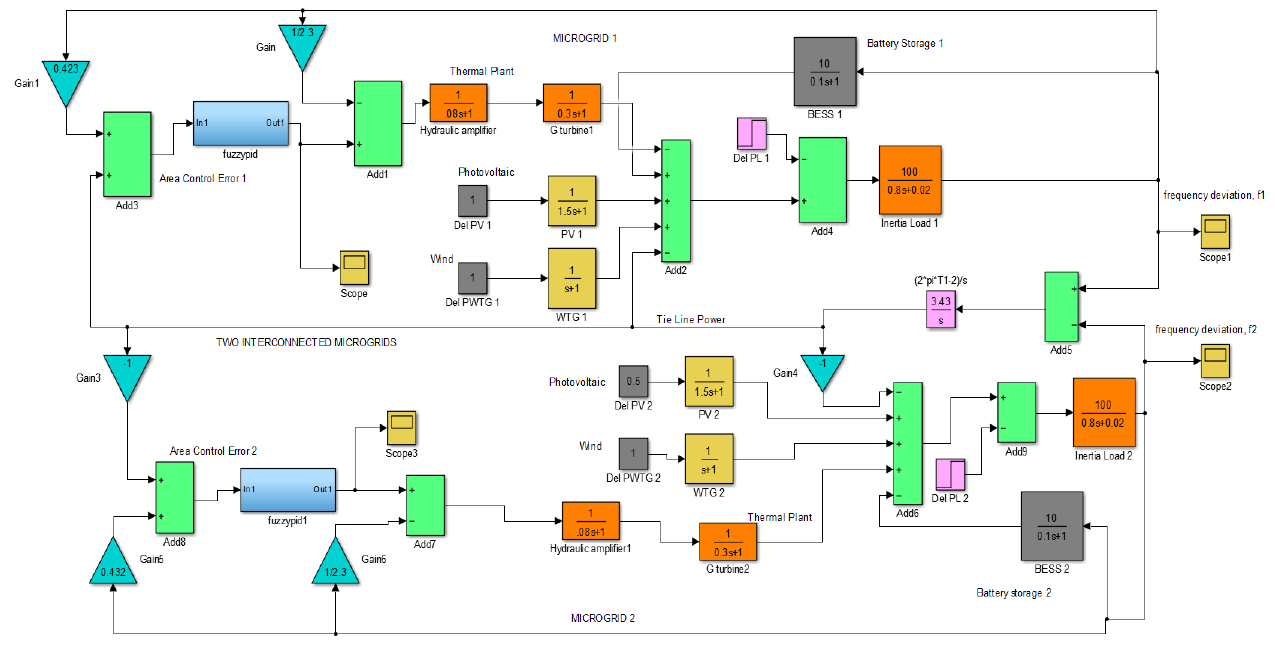
Figure 10. MATLAB Model of Interconnected